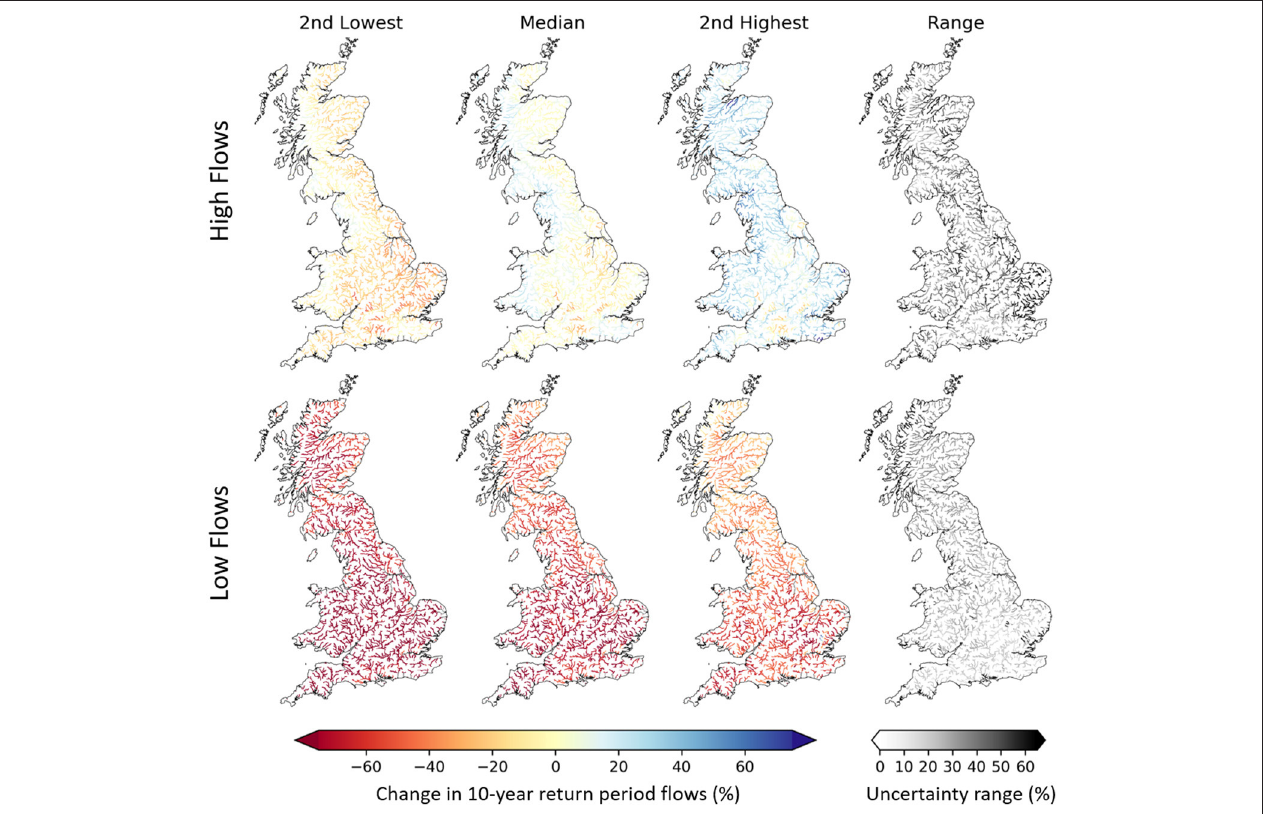
FIGURE 4 | Percentage change in 10-year return period high (top row) and low (bottom row) flows. The left three plots summarise the projected changes from all 12 ensemble members, giving the second lowest, median, and second highest result for each river pixel. The right hand plot shows the ensemble spread as an indicator of projection uncertainty, calculated as the difference between the second lowest and second highest projection for each river pixel.